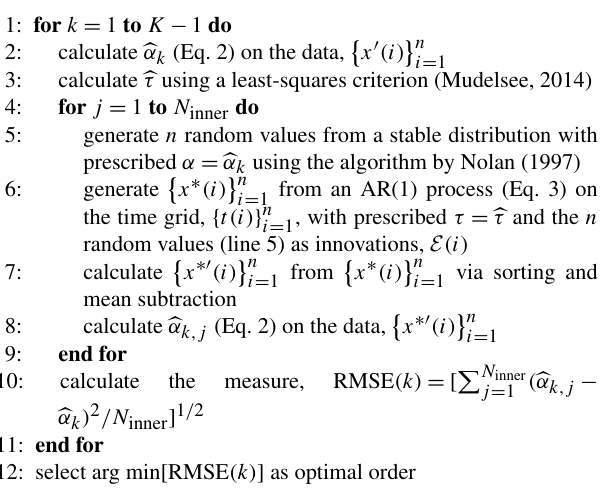
Algorithm 1 Optimal order selection for the Hill estimator.